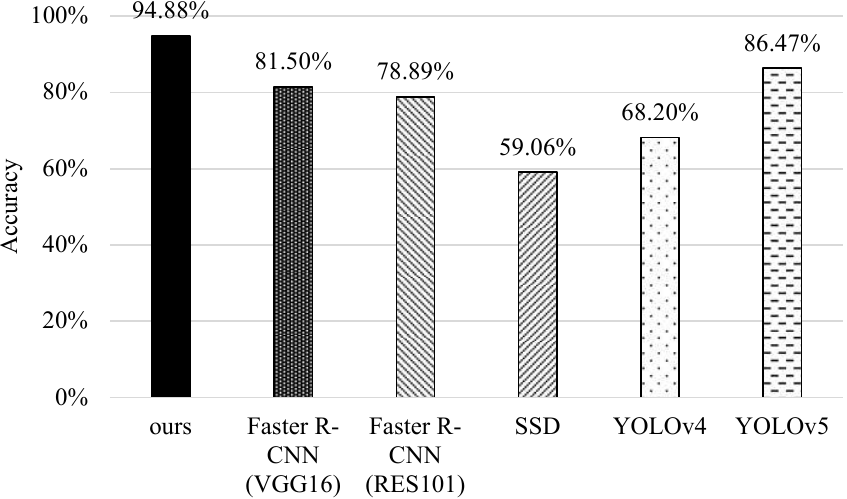
Figure 16. Comparisons of accuracy of different methods.